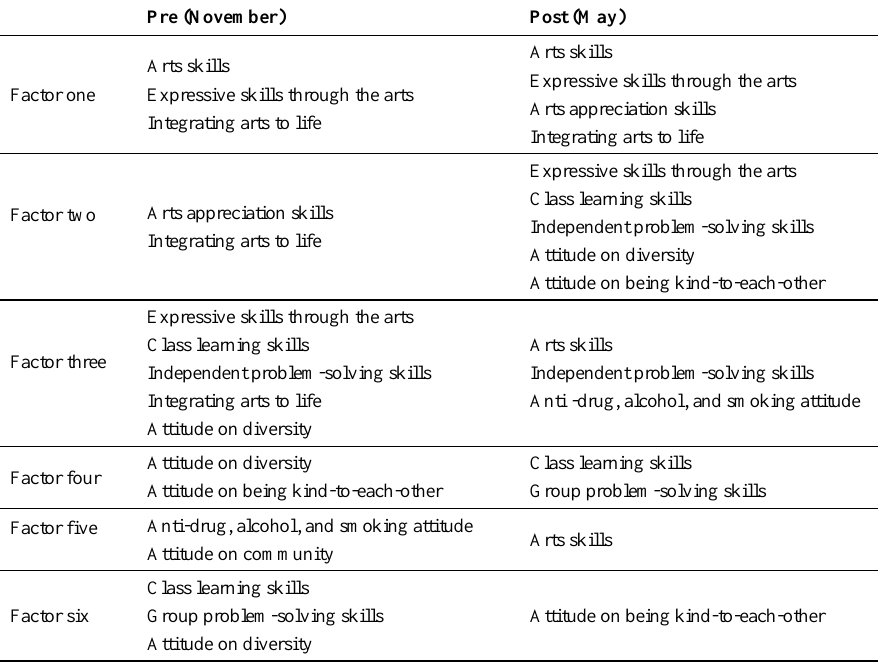
Table 3. AAGTD Factor Analysis Summary: Relationships among Skills and